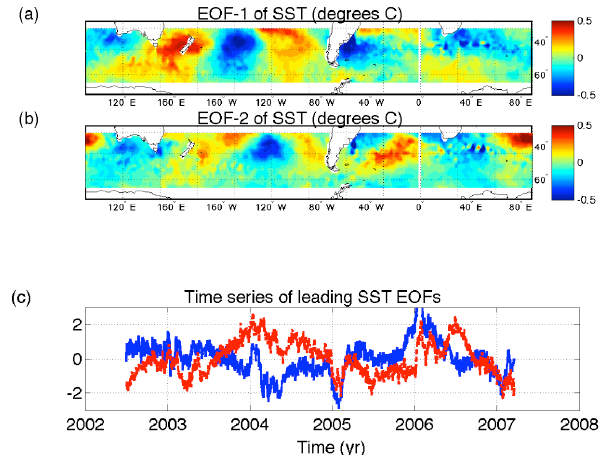
Figure 5. Leading EOFs of SST: (a,b) EOFs 1 and 2; and (c) corresponding PCs (PCs 1 and 2 2 Fig. 5. Leading EOFs of SST: (a, b) EOFs 1 and 2; and (c) corre- are shown as blue and red lines, respectively). 3 sponding PCs (PCs 1 and 2 are shown as blue and red lines, respec- tively).